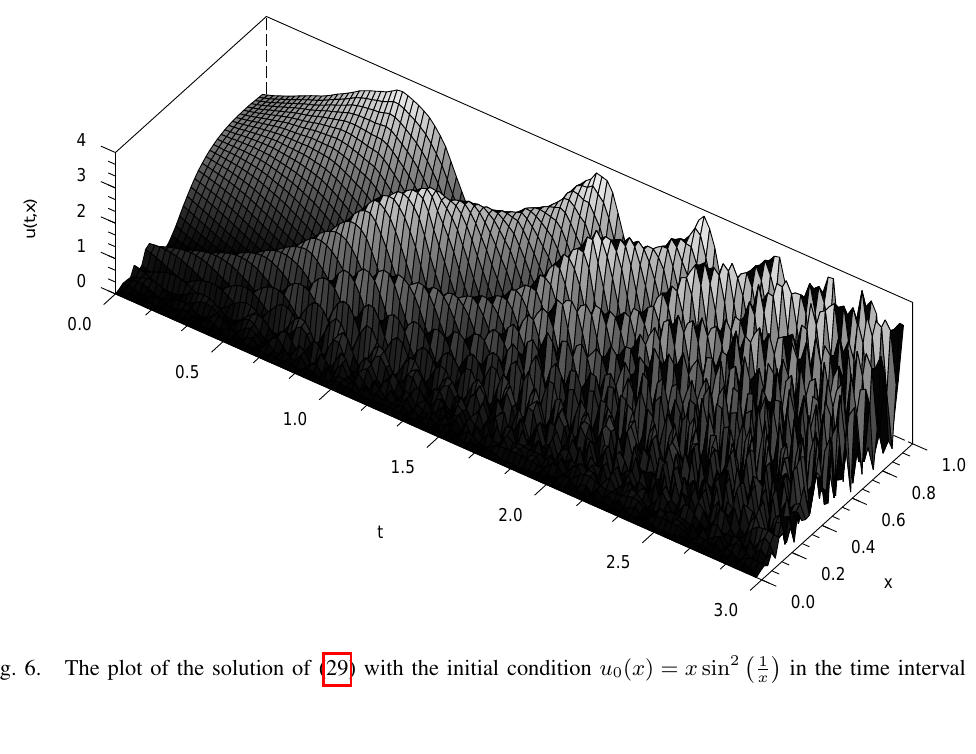
Fig. 6. The plot of the solution of (29) with the initial condition u 0 ( x ) = x sin 2 (cid:0) 1